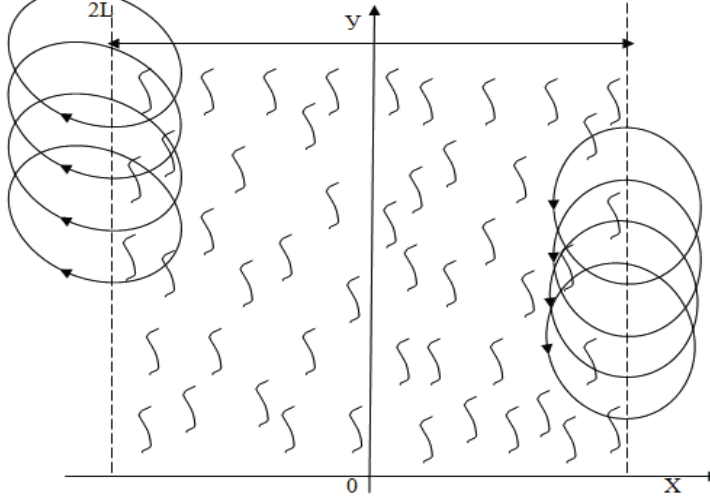
Fig. 1. Derivation of equations for calculating the distribution of the concentration of foreign impurities and